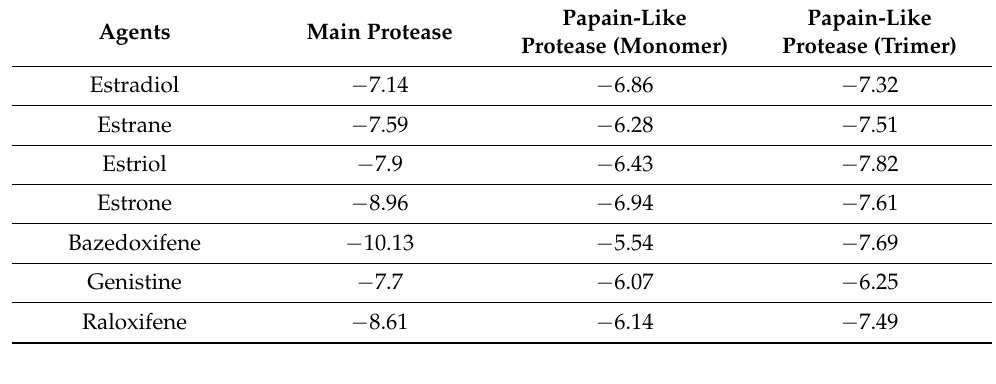
Table 2. The calculated interaction energy between SARS − CoV − 2 proteases and estrogens or ERMs (kcal/mol).